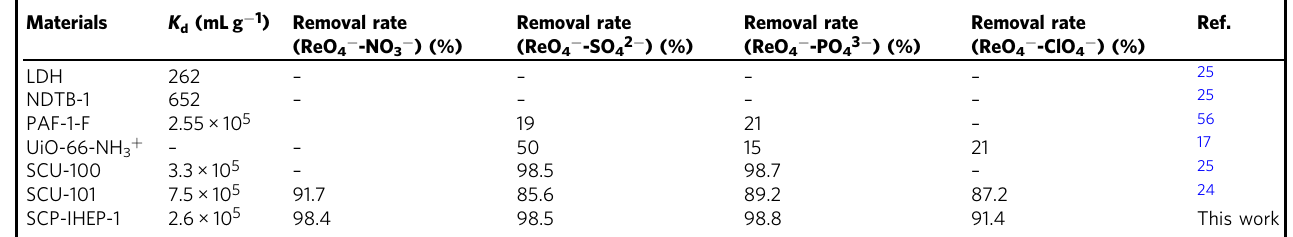
Table 1 Comparison of ReO 4 − removal performance between different cationic materials Materials